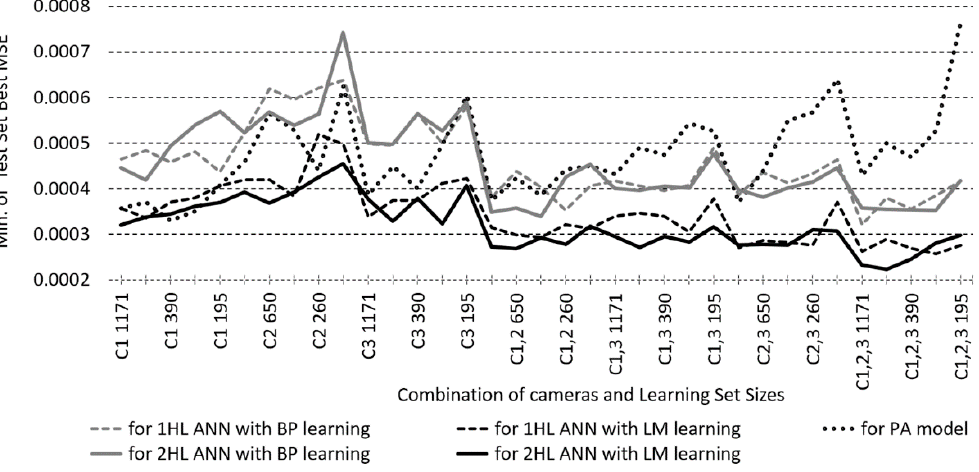
Figure 8. Minimum of Test Set Best MSEs searched through all first and second hidden layer number of neurons combinations, according to one and two hidden layer ANNs (1/2HL) modelled with BP or LM learning algorithm and for the polynomial approximation models (PA).